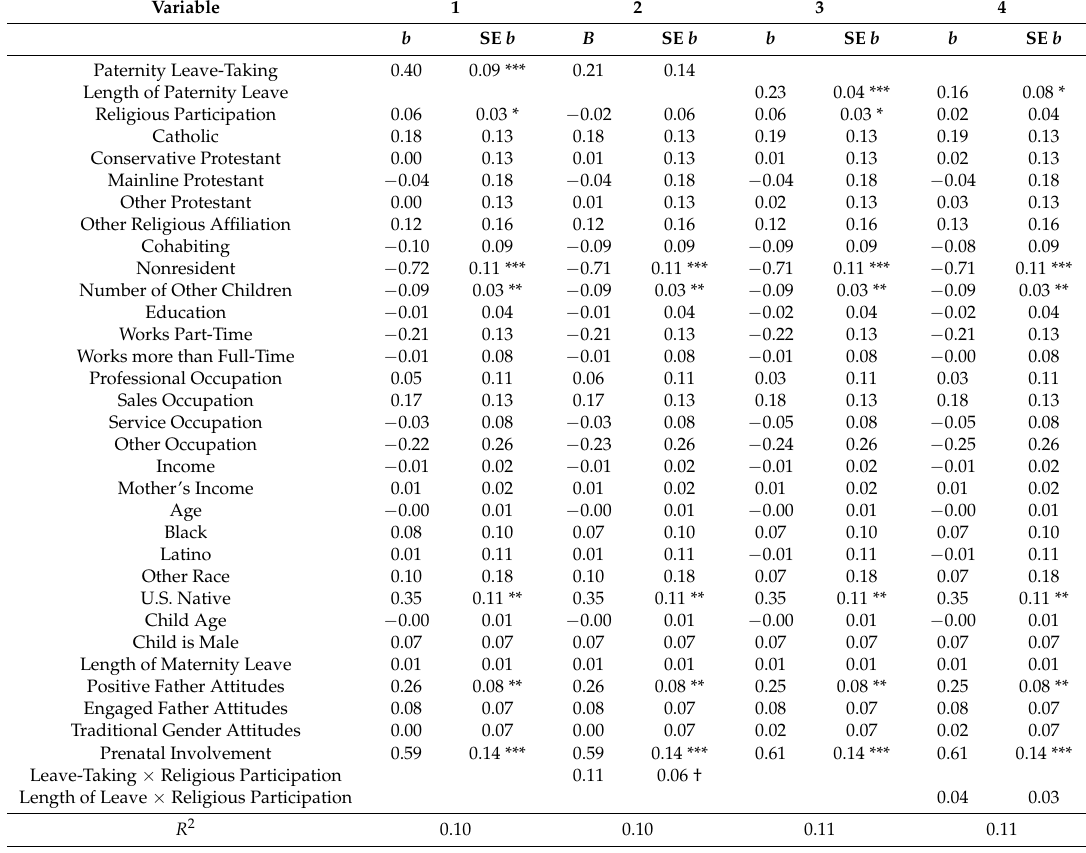
Table 2. Results from OLS regression models predicting father